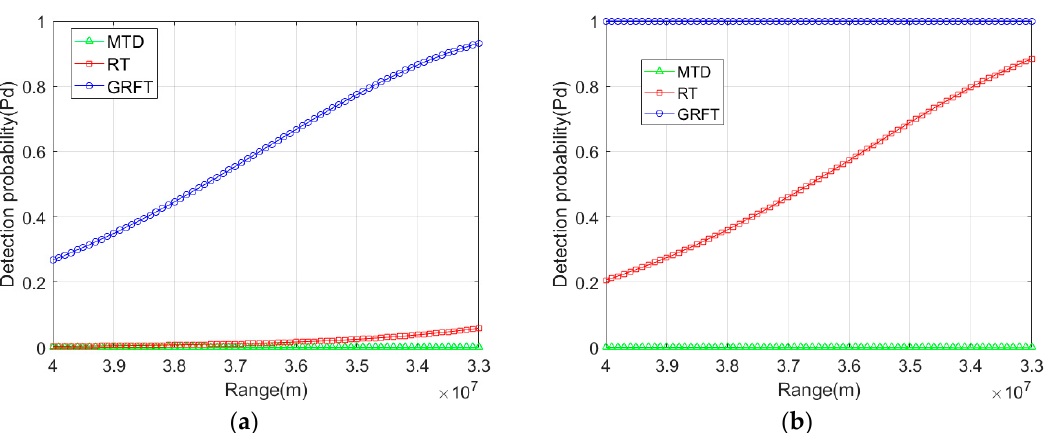
Figure 9. The detection probability for different integration methods: ( a ) when integration time equals to 10 s; and, ( b ) when integration time equals to 100 s.